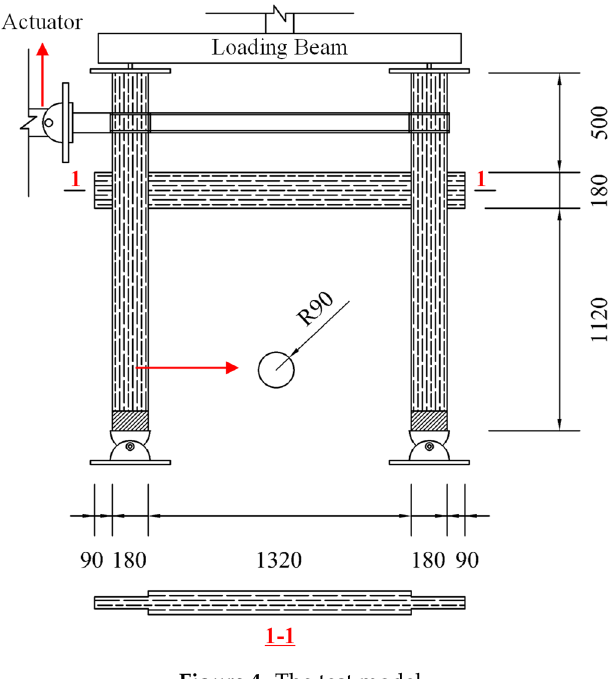
Figure 4. The test model.